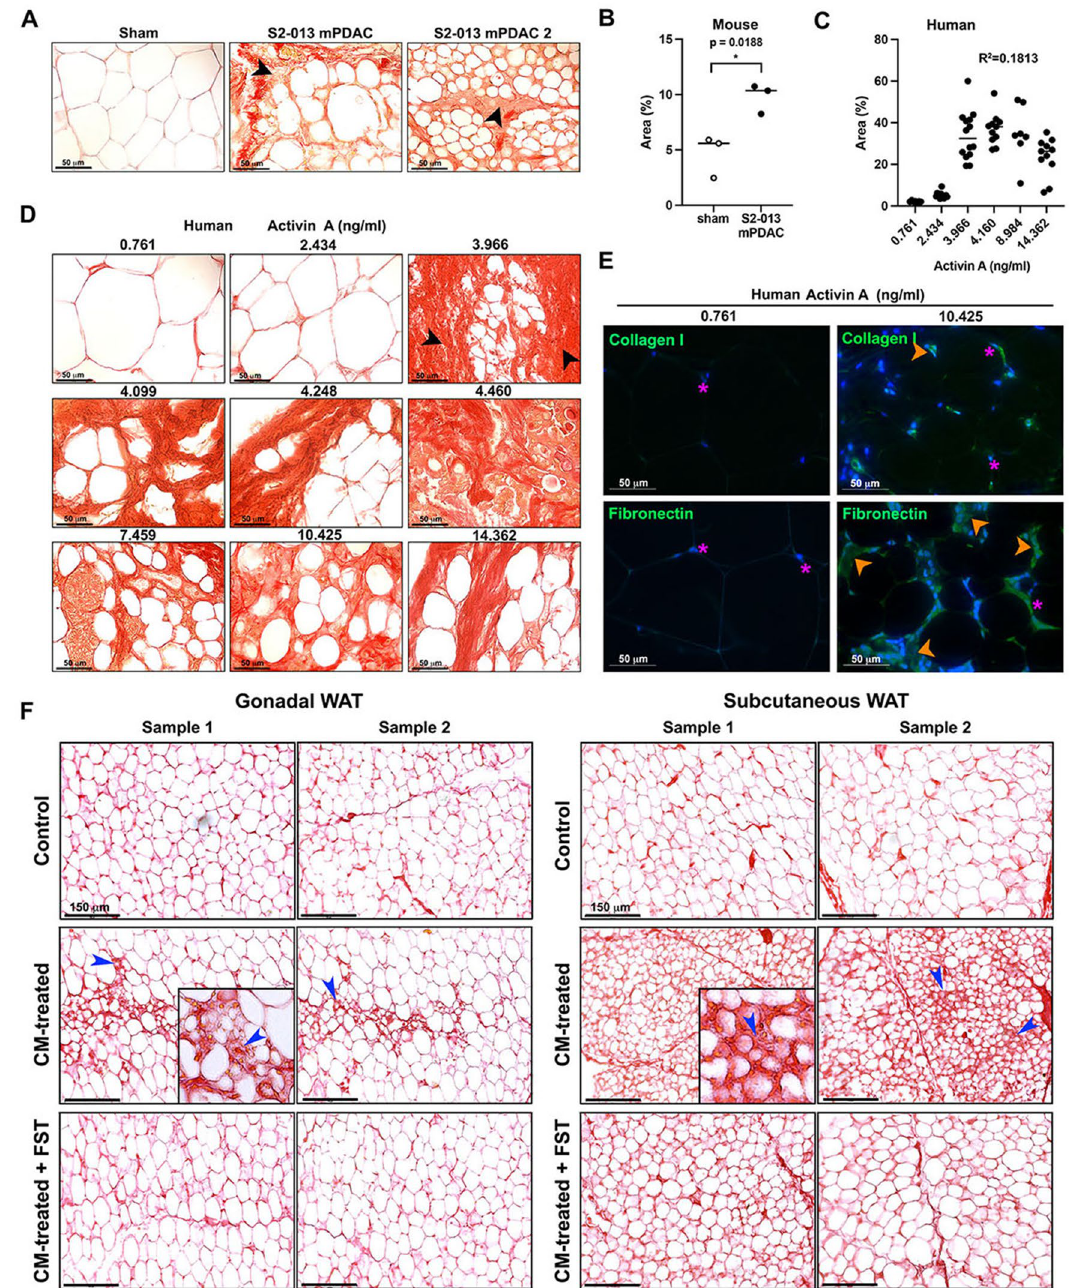
Figure 8. Fibrotic remodeling of visceral adipose tissue in PDAC patients and an orthotopic implantation model appears to correlate with activin A. ( A ) Picro-Sirius Red staining of gonadal adipose tissue of sham control and S2-013 mPDAC. Arrows indicate areas of collagen deposition. ( B ) Picro-Sirius Red staining of visceral adipose tissue in PDAC patients with corresponding activin A levels in ng/ml. Arrows indicate areas of collagen deposition. ( C ) Area percentage of red pixels indicating collagen I/III deposition in gonadal adipose tissue from sham control and S2-013 mPDAC as measured by Image J. The average area percentage of red pixels from each animal was marked with a dot. ( D ) Area percentage of red pixels indicating collagen I/III deposition in visceral adipose tissue from PDAC patients with corresponding activin A levels in ng/ml. The areas of collagen I/III deposition were measured from several histological sections. 7 sections, 0.761 ng/ml; 13 sections, 2.434 ng/ml; 14 sections, 3.966 ng/ml; 11 sections, 4.160 ng/ml; 7 sections, 8.984 ng/ml; 11 sections, 14.362 ng/ ml. Each dot indicates the area per section. ( E ) Immunofluorescence images with collagen I and fibronectin in visceral adipose tissue from patients with low and high serum activin A in ng/ml. Nuclei were stained with DAPI. Purple stars indicate adipocyte nuclei, while orange arrows indicate areas of signal. Scale bar = 50 µm for all microscope images. ( F ). Picro-Sirius Red staining of gonadal and subcutaneous white adipose tissue (WAT) obtained from C57BL/6 mice and cultured ex vivo with RPMI1640 (control), CM from KPC8069 cells, or CM from KPC8069 cells supplemented with FST288. Blue arrows indicate areas of collagen